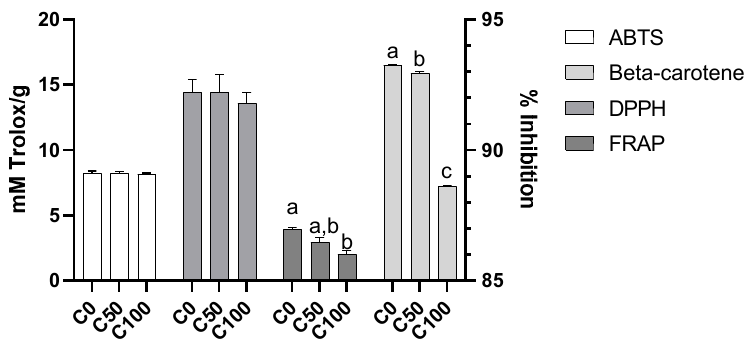
Figure 2. Antioxidant activity was recorded using the ABTS, DPPH, and FRAP assays (all mM Trolox/g) and β -carotene bleaching assay (% inhibition). Different small letters (a–c) indicate significant differences at p < 0.05 according to the analysis of variance (ANOVA) and multiple range test (Tukey’s test). C0—control treatment with water; C50, Superfifty at 0.5 L/ha; C100, Superfifty at 1 L/ha.